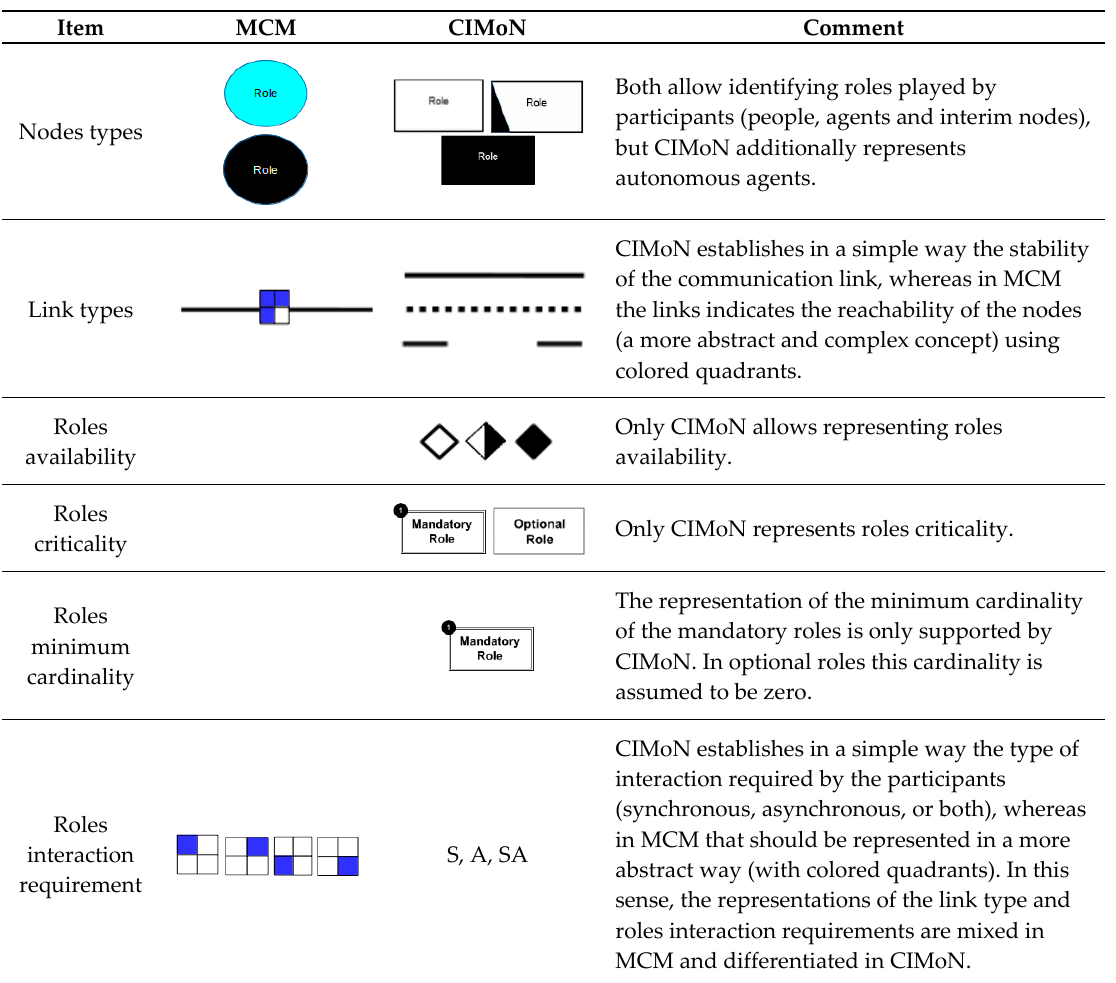
Table 9. Comparison of expressiveness aspects of MCM and